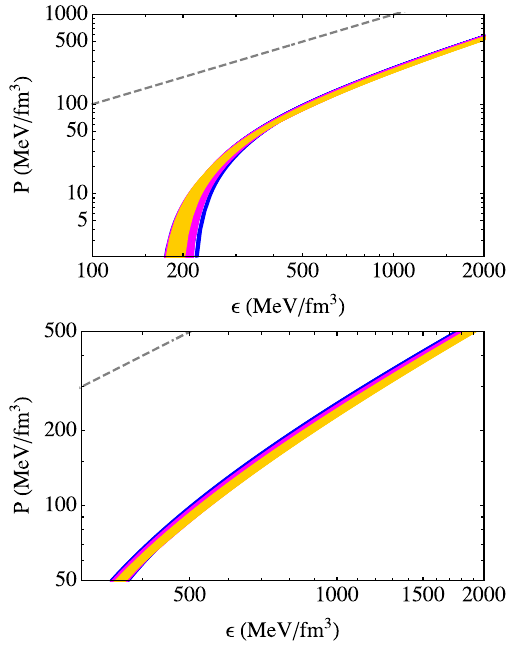
Fig. 2 Equations of state for strange quark stars selected by the con- straints of M TOV > 2 M (cid:2) and (cid:2) 1 . 4 < 800. The gray-dashed line stands for P =